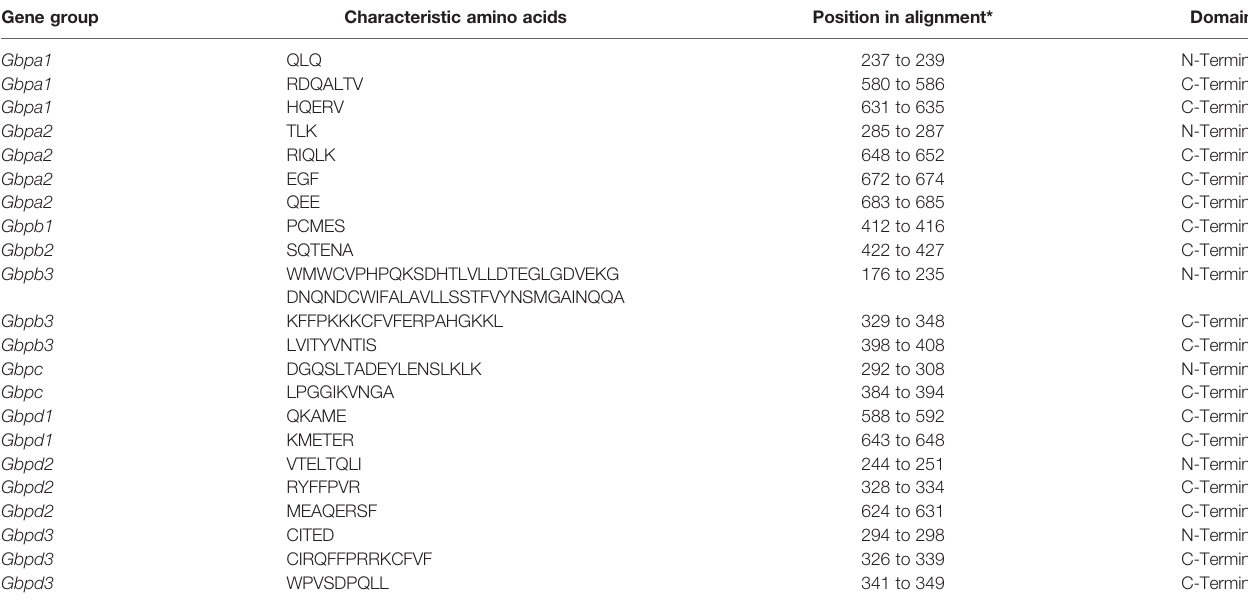
TABLE 1 | Speci fi c amino acids of the new Gbps of muroids. Gene group